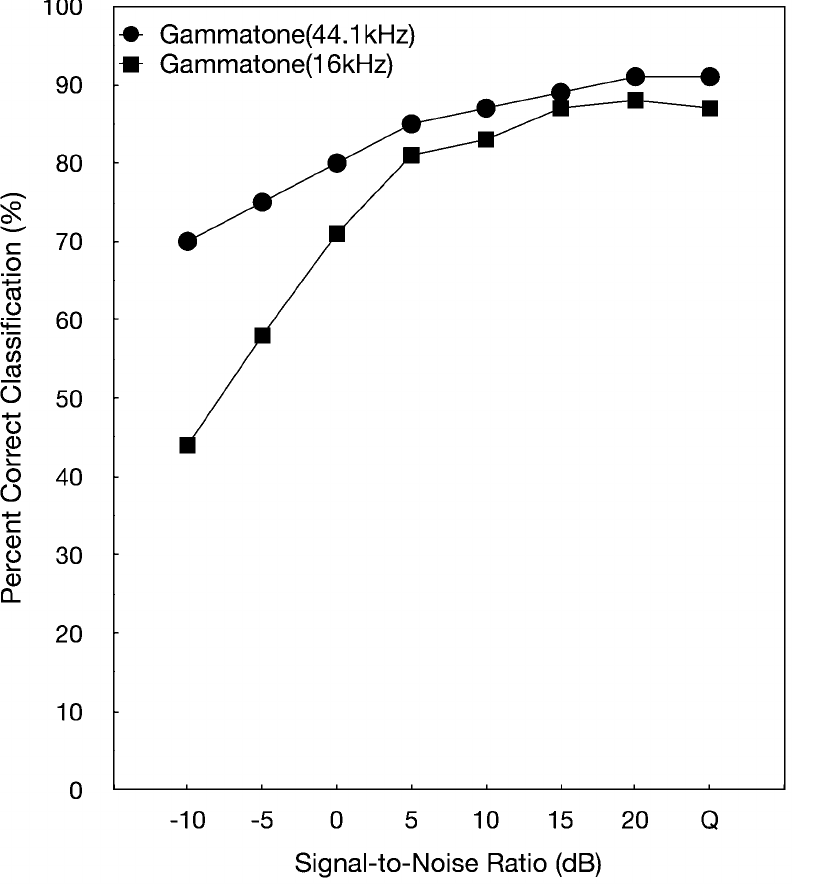
Figure 3. Overall fricative classification accuracy observed in quiet and at seven SNRs ranging from + 20 to 2 10 dB of speech materials with sampling rates equal to 16 kHz and 44.1 kHz.